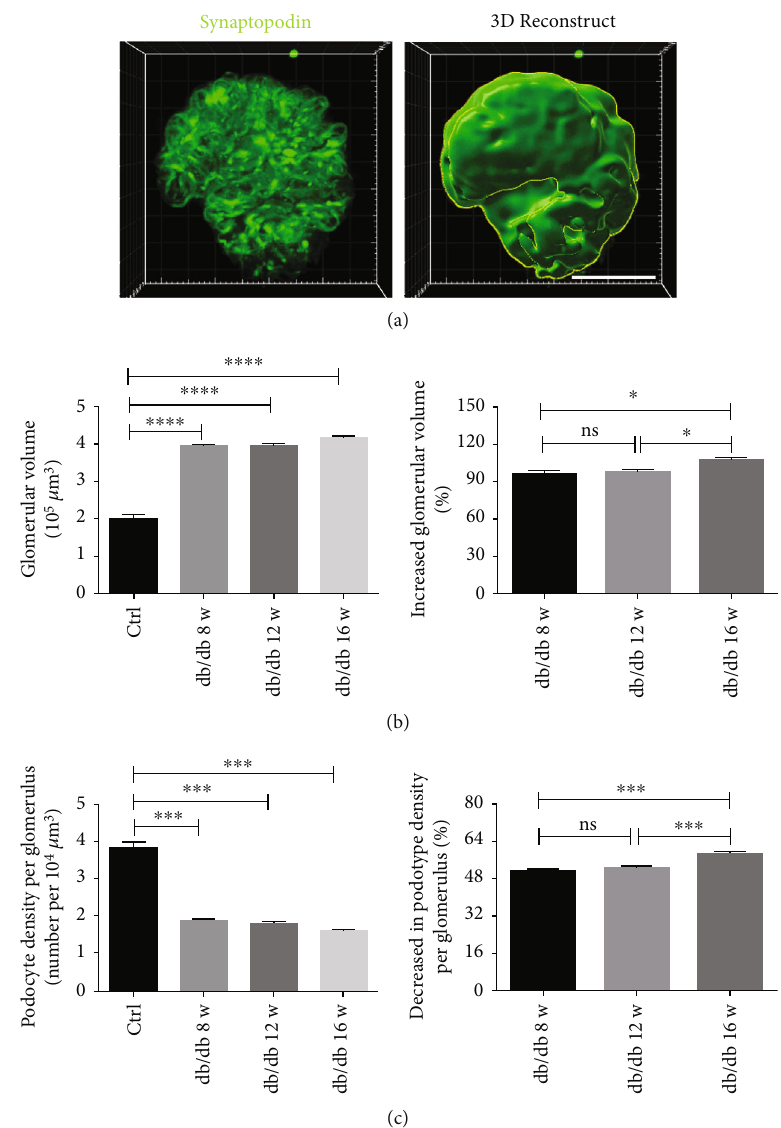
Figure 6: Relative podocyte decrease of whole glomerulus in db/db mice. (a) Three-dimensional visualization of podocytes labeled with synaptopodin was expanded to obtain a 3D reconstruction of the whole glomerulus as glomerular volume (scale bar, 50 μ m). (b) db/db mice had signi fi cantly increased glomerular volume, compared with the control group (at least 80 glomeruli per group), which there was a more marked increase in db/db mice with age of 16w. The increased glomerular volume rate was calculated through the di ff erence of mean glomerular volume between each db/db mice (at least 25 glomeruli per mouse) and the control group divided by mean glomerular volume in the control group (80 glomeruli). Data are expressed as mean ± SEM ; ∗ P < 0 : 05 , ∗∗∗∗ P < 0 : 0001 . (c) A statistically signi fi cant decrease in podocyte density per glomerulus in db/db mice with a remarkable decrease podocyte density per glomerulus by the age of 16w was presented by column diagrams. Podocyte density per glomerulus of each group was calculated through mean total podocyte number per glomerulus divided by glomerular volume. Decrease in podocyte density per glomerulus of each group was calculated through di ff erence of podocyte density per glomerulus between each db/db mice and the control group divided by mean podocyte density per glomerulus in the control group. Data are expressed as mean ± SEM ; ∗∗∗ P < 0 : 001